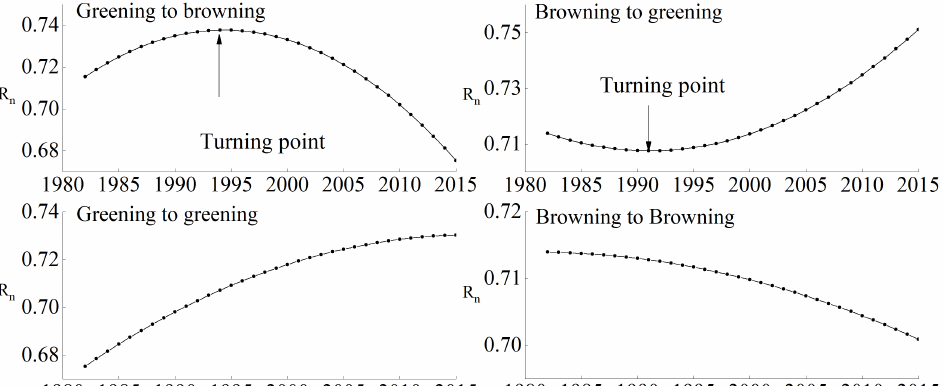
Figure 2. Four different types of NDVI EEMD